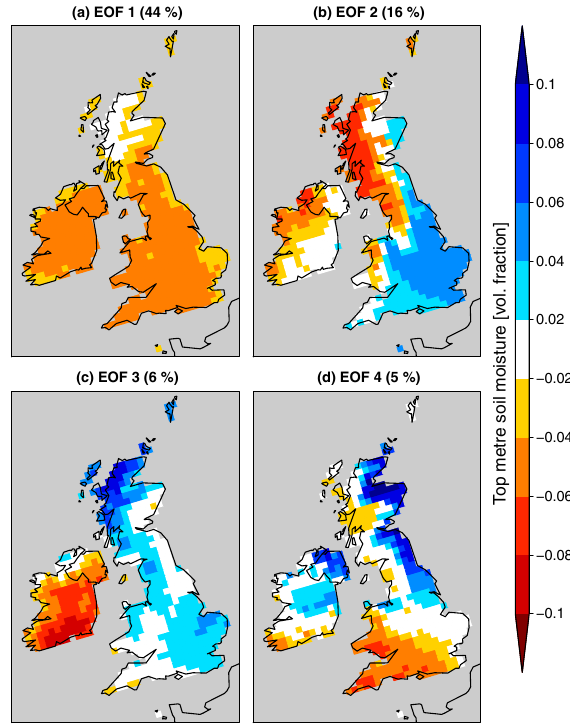
Figure 2. Leading EOFs of upper 1m soil moisture over the British Isles in the last pentad in December. The fraction of explained vari- ance is indicated on each